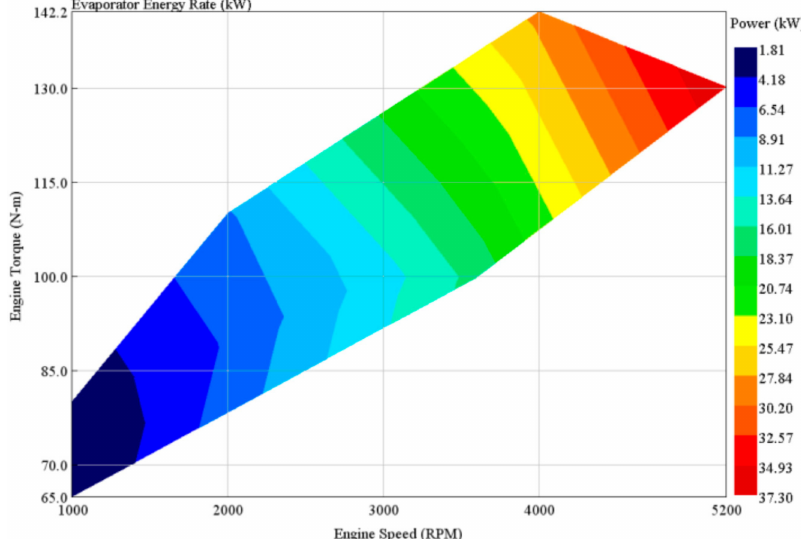
Figure 23. Evaporator Energy Rate.